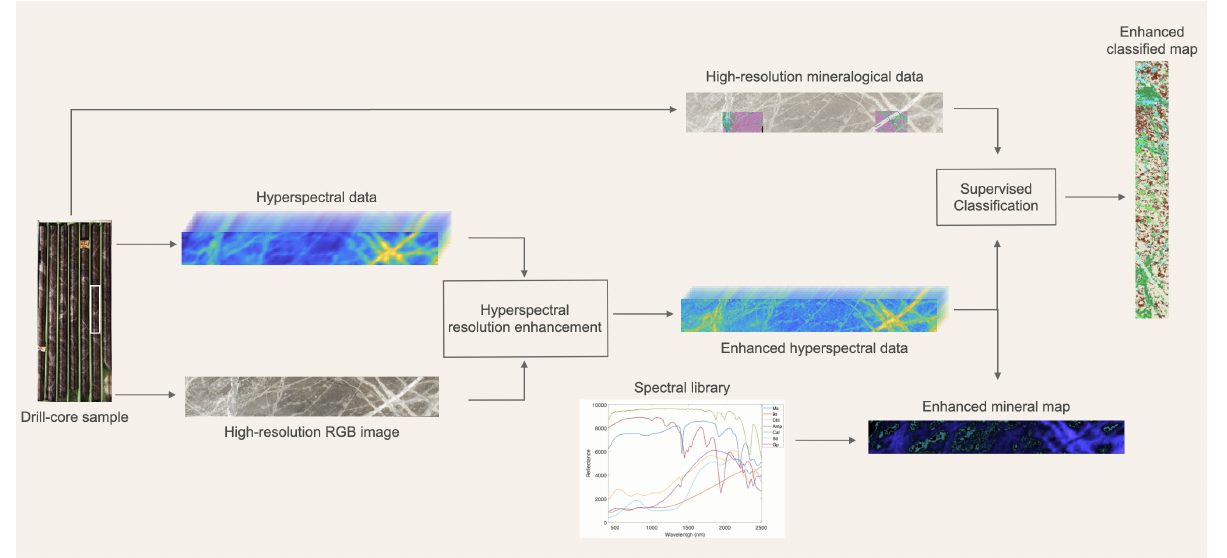
Figure 1. Flowchart of the proposed methodology to map minerals at a high-spatial resolution using hyperspectral